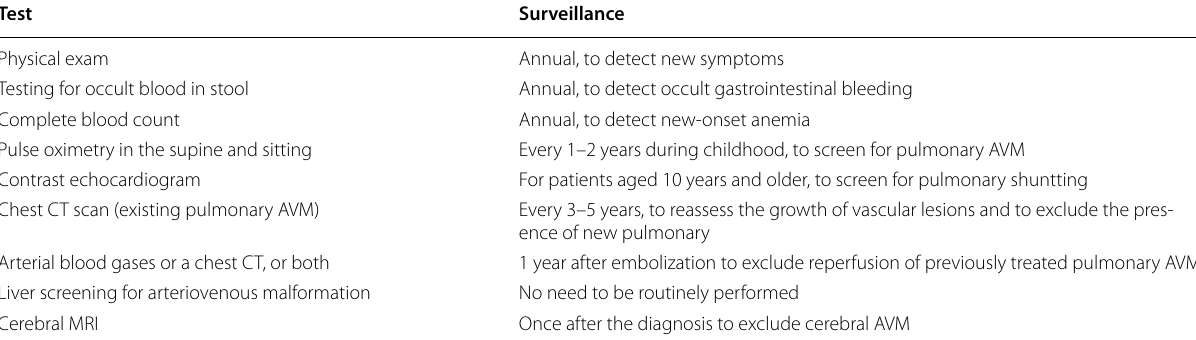
Table 3 Osler‑Weber‑Rendu disease monitoring [6] Test Surveillance Testing for occult blood in